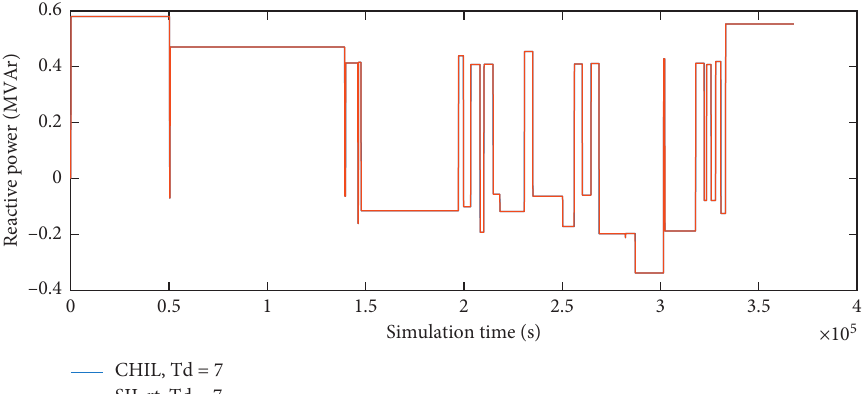
Figure 16: Real-time SIL simulation and CHIL results. Reactive power flow of the WTconverter when T to the TSO limits of ± 50 kVAr, except QD 1 � Q i +200